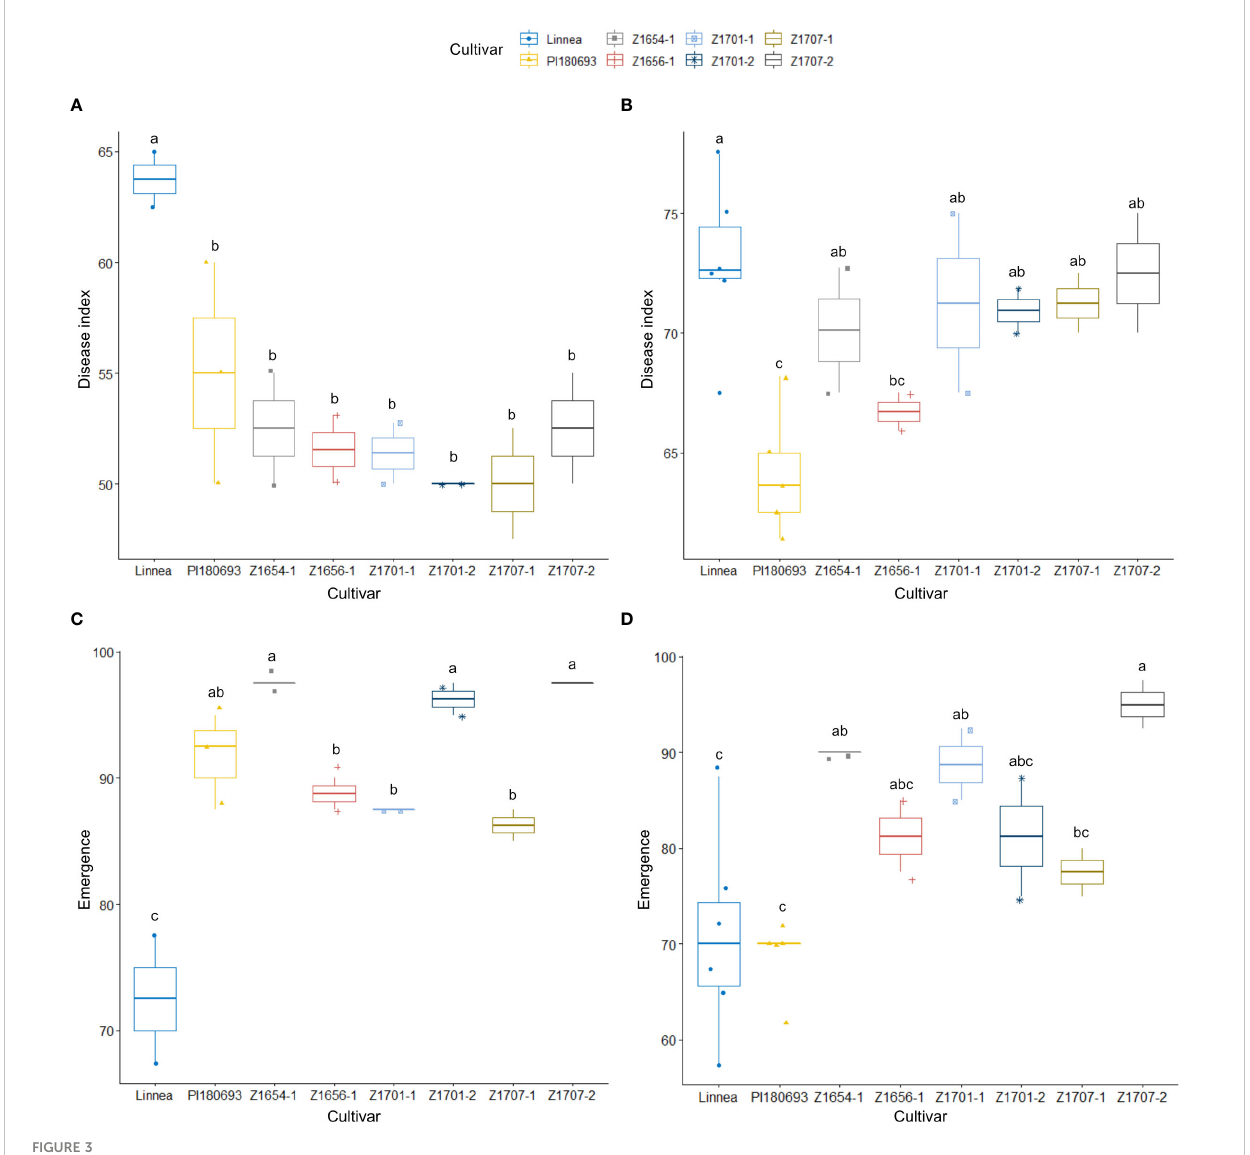
FIGURE 3 Disease index scores and emergence rates in 2020 fi eld trials. Disease index scores (A) and emergence rates (C) for fi eld Z20EA and fi eld Z20EB with co- occuring P. pisi , (B , D) , respectively, are averages of two replicates for every breeding line and additional replicates for PI180693 and Linnea. Disease index is measured on a scale from 0 (completely healthy plant) to 100 (completely diseased) and emergence levels indicate the percentage of plants emerged compared to seeds sown. Letters a-c indicate Fisher ’ s signi fi cant ( p > 0.05) differences between means of disease indexes and emergence